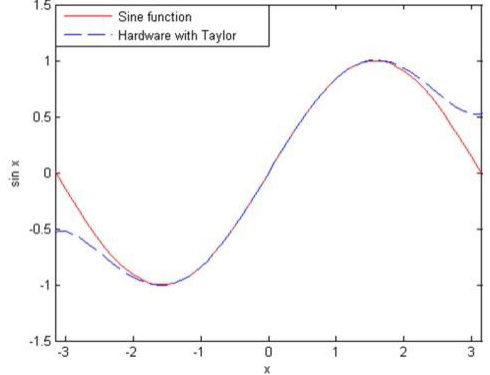
Figure 12. Block diagram of the cosine function with the Taylor expansion.